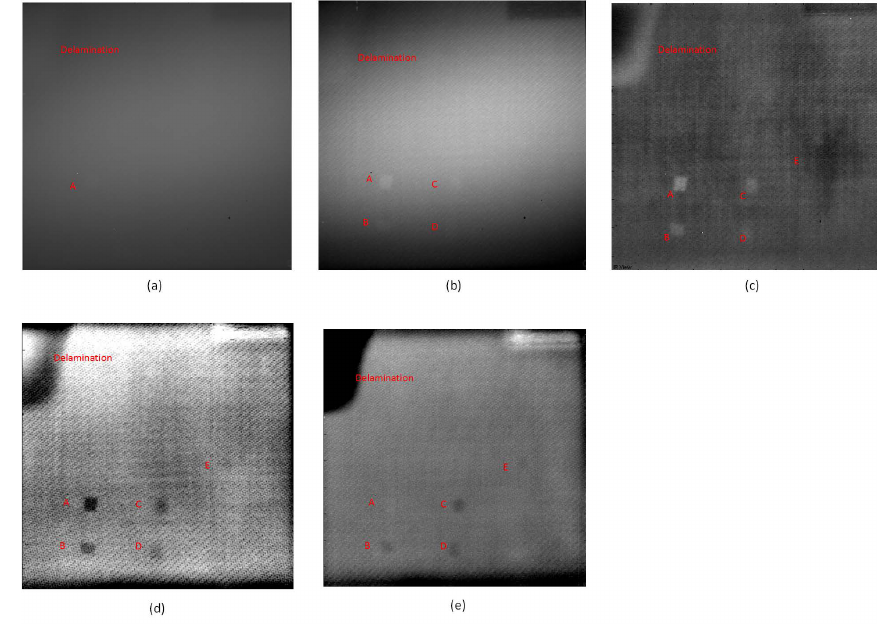
Figure 3. The pulsed thermography results: ( a ) Raw image; ( b ) After CIS; ( c ) PCT: EOF 5; ( d ) B-TSR: 1st derivative; ( e ) B-TSR: second derivative.